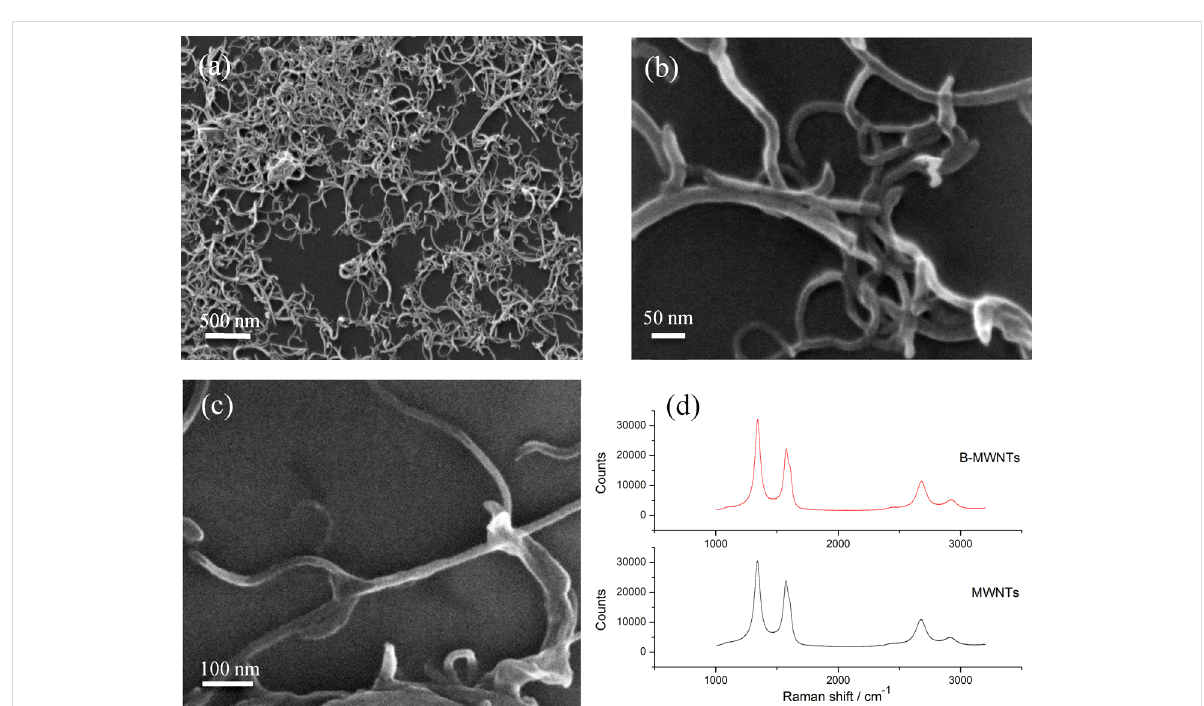
Figure 2: a) Helium ion microscope (HeIM) overview of b-MWCNTs and b) HeIM detail of b-MWCNTs; c) SEM detail of unzipped and branched- MWCNTs; d) Raman spectra of as received MWCNTs (bottom spectrum) and b-MWCNTs (top spectrum) – both at 532